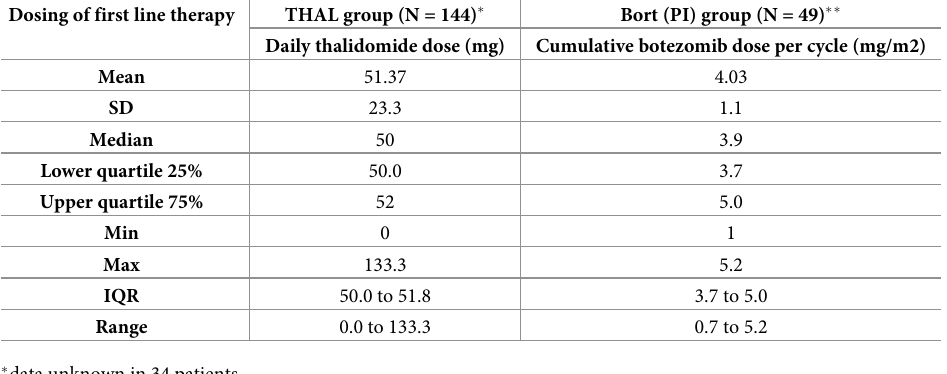
Table 2. Dose intensity of thalidomide and bortezomib at first line therapy. Dosing of first line